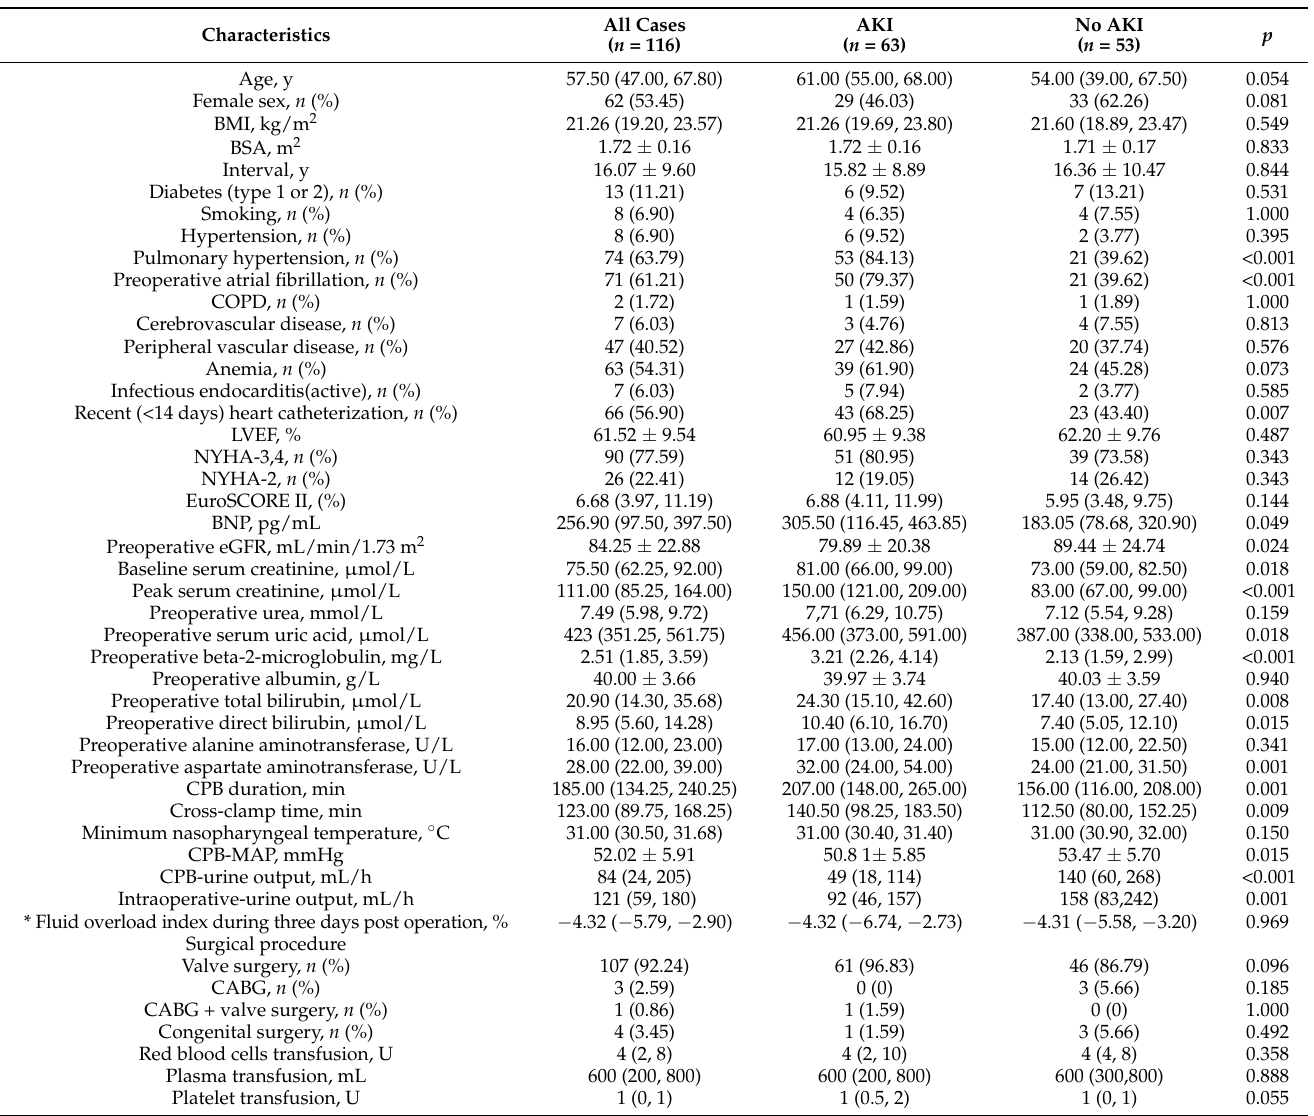
Table 1. Demographics and clinical characteristics of patients undergoing redo cardiac surgery with cardiopulmonary